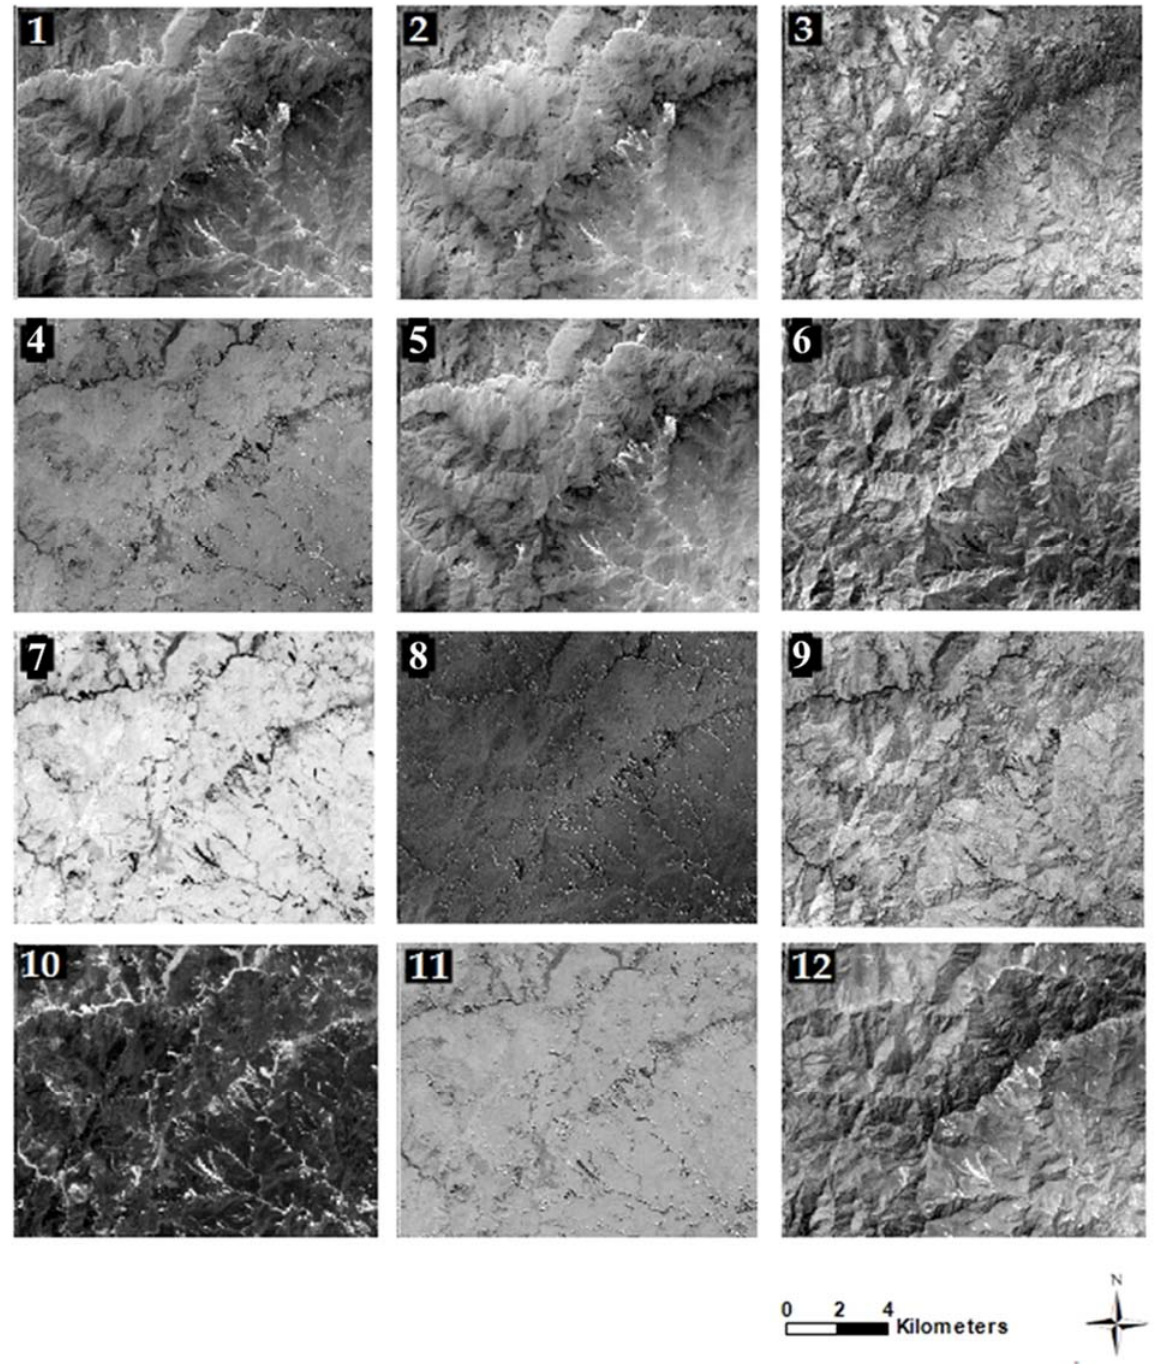
Figure 10. Reconstructed deep features of Taiwan’s case study. The stack of MNF features, slope, and NDVI layers were fed to our optimized CAE model (optimal parameters achieved in the tuning process), and the model’s outputs were 12 reconstructed features of the input data.